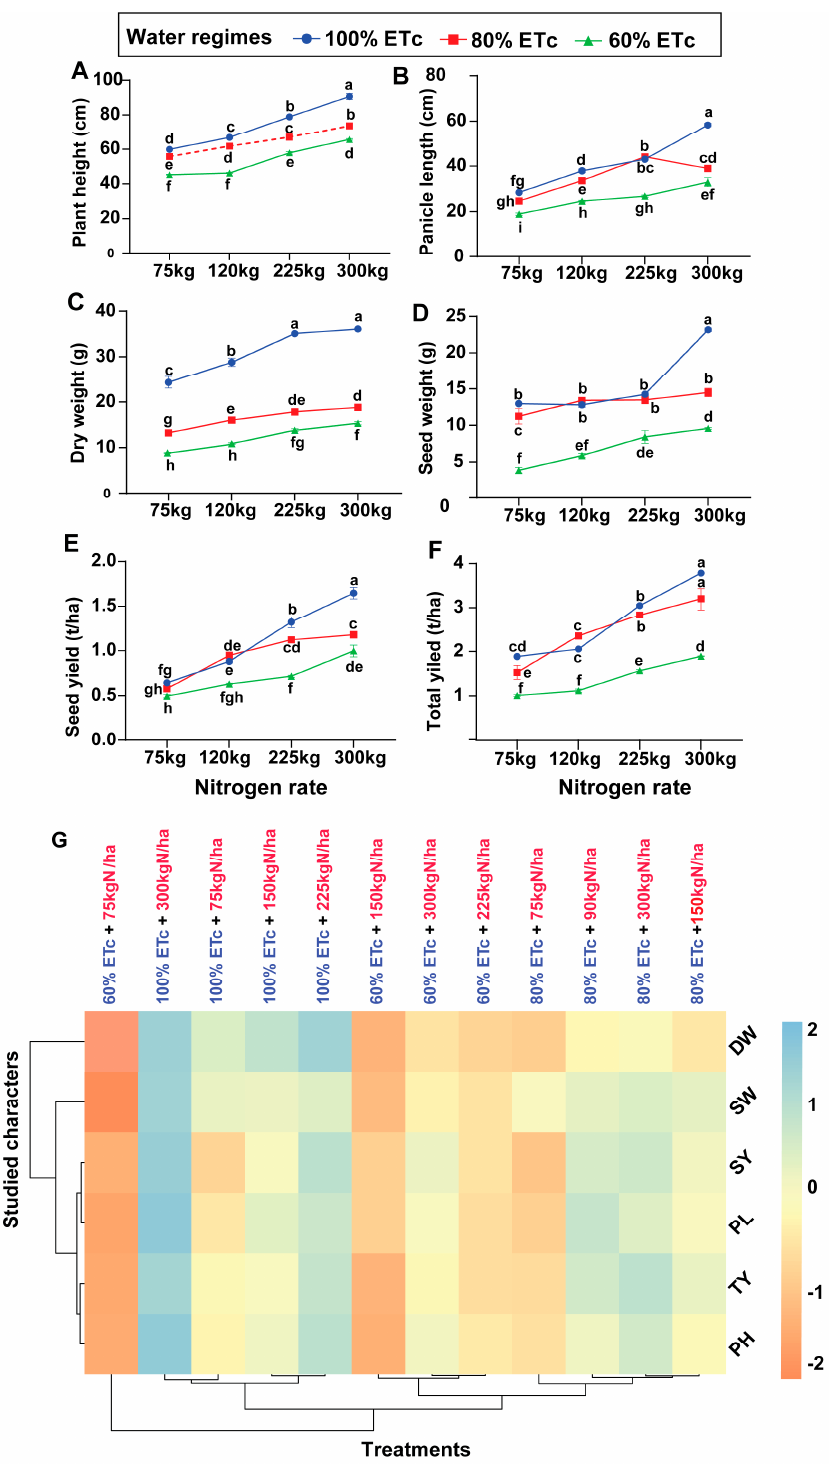
Figure 2. Line plots showing the effects of different nitrogen levels under various water regimes on plant height (cm) ( A ), panicle length (cm) ( B ), dry weight (g) ( C ), seed weight (g) ( D ), seed yield (t/ha) ( E ), and total yield (t/ha) ( F ) of quinoa, averaged among the two growing seasons of 2020/21 and 2021/22 at Arab El-Awammer Research Station. A heatmap showing the performance of each studied trait with different combinations of both water regimes and nitrogen levels ( G ). PH: plant height; EL: panicle length; DW: dry weight; SW: seed weight; SY: seed yield; TY: total yield. Different lowercase letters in the figure indicate significant